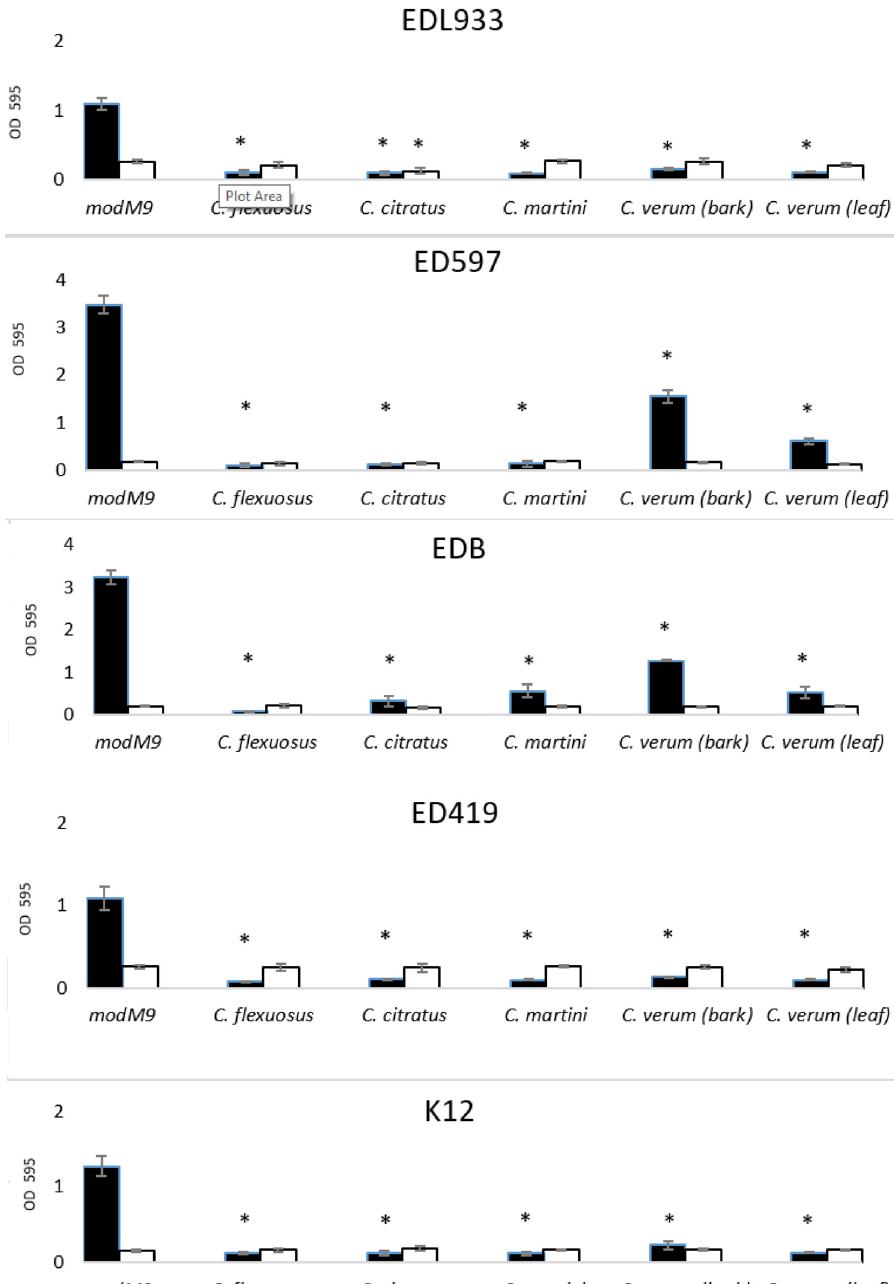
Figure 1. Antibacterial and antibiofilm activity of EOs on E. coli strains. Planktonic growth (white bars) and biofilm formation (black bars) were quantified in modM9 and in modM9 in the presence of EOs, after culture of 24 h in 96-well plates, at 28 ◦ C. Data are presented as mean ± SD of absorbance (at 595 nm). * p <